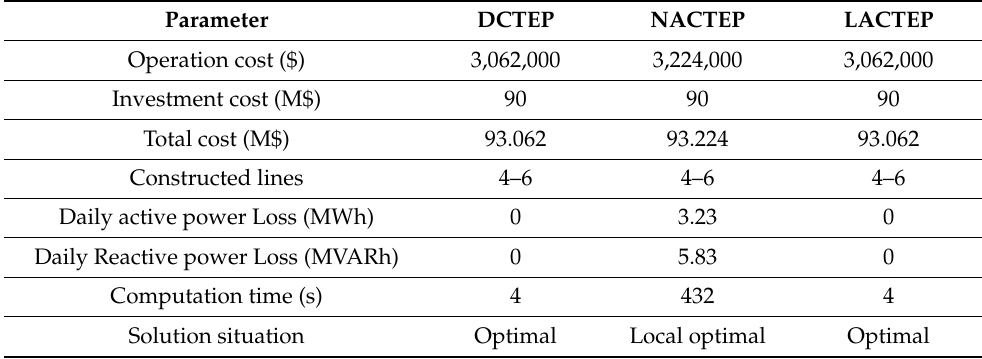
Table 5. Results of different factors in 6-bus network for different power flow methods.